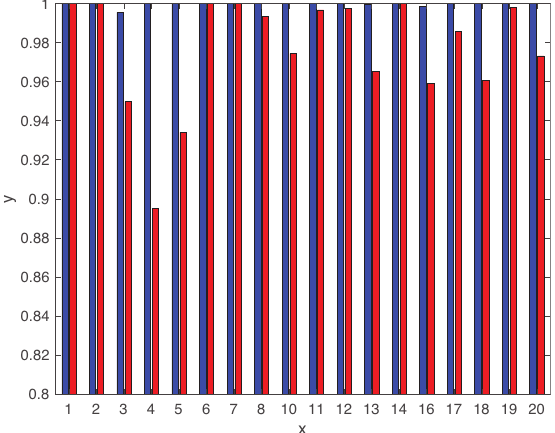
Figure 10. Area under the curve (AUC) using both LSTM and DCNN for 18 different types of